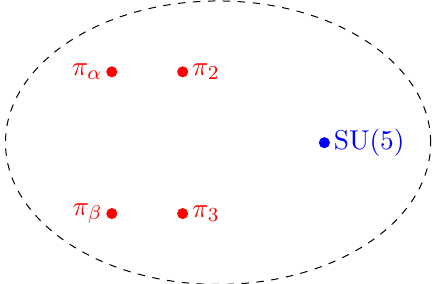
Table 3 . The 4 junctions corresponding to the highest weight state of Λ 2 of SU(5) near the point of enhancement z = a = 0 . The middle column is the charge of the state under the Cartan U(1) ’s 10 of SU(5) . a ( J ) is computed with respect to S . G